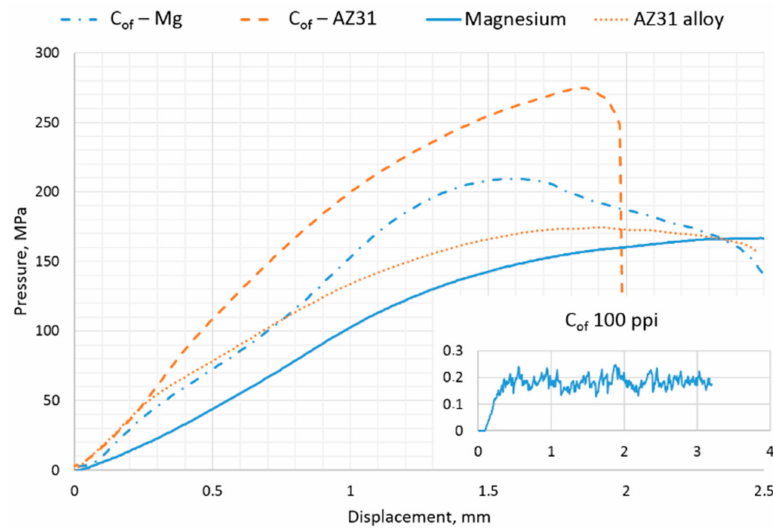
Figure 8. Typical curves of compressive strength tests obtained for manufactured composites and applied components-matrix alloys and carbon foam.